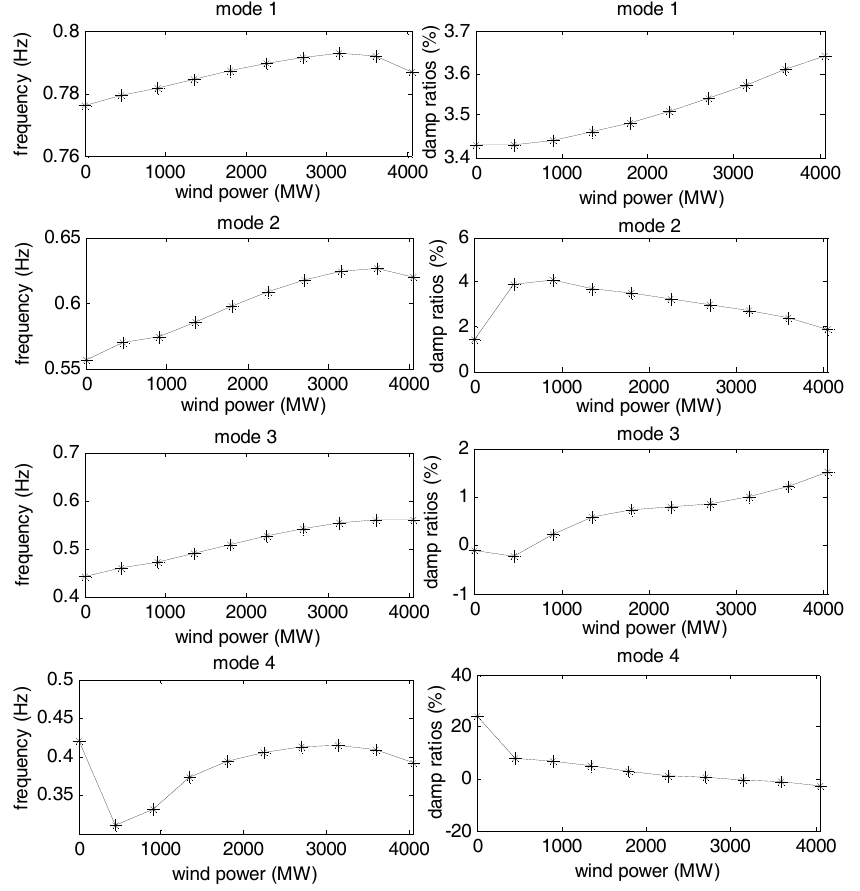
Figure 7. Variation of frequency and damp ratio of oscillation modes with wind power output.